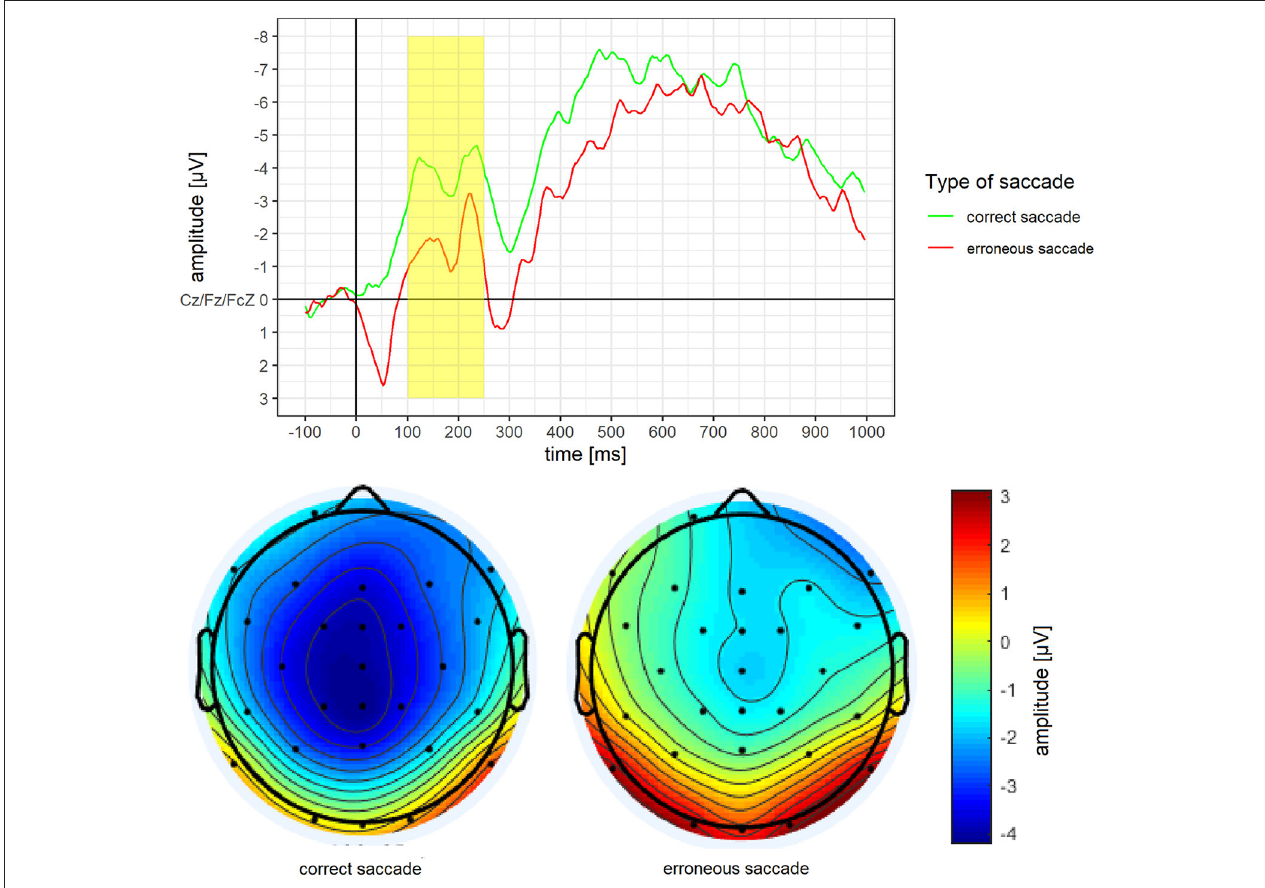
FIGURE 3 | Grand average difference wave of the N2 separately for erroneous and correct saccades. Underneath a scalp map displaying the mean voltage distribution for erroneous and correct saccades in the time window ranging from 100 to 250ms after stimulus onset.